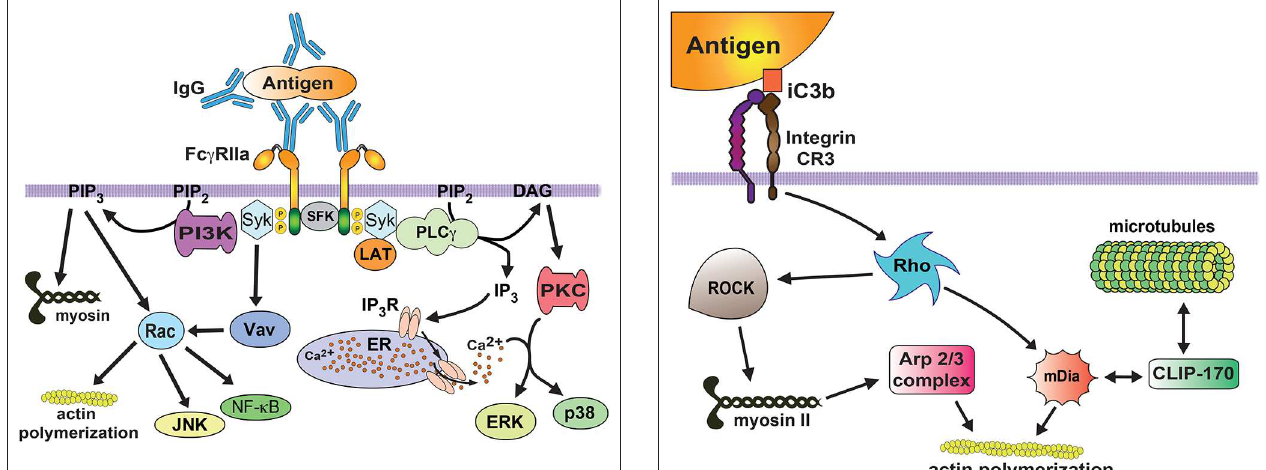
FIGURE 4 | Fc γ R signaling for phagocytosis. Fc γ RIIa crosslinking by immunoglobulin (IgG) bound to a particle, induces activation of Src family kinases (SFK), which phosphorylate tyrosine residues in the ITAM sequence within the cytoplasmic tail of the receptor. Then, spleen tyrosine kinase (Syk) associates with phosphorylated ITAMs and leads to phosphorylation and activation of a signaling complex formed by the scaffold protein LAT (linker for activation of T cells) interacting with various proteins. One of these proteins is phospholipase C gamma (PLC γ ), which produces inositoltrisphosphate (IP 3 ), and diacylglycerol (DAG). These second messengers cause calcium release and activation of protein kinase C (PKC), respectively. PKC leads to activation of extracellular signal-regulated kinases (ERK and p38). The guanine nucleotide exchange factor Vav activates the GTPase Rac, which is involved in regulation of the actin cytoskeleton. Rac is also involved in activation of transcription factors such as NF- κ B and JNK. The enzyme